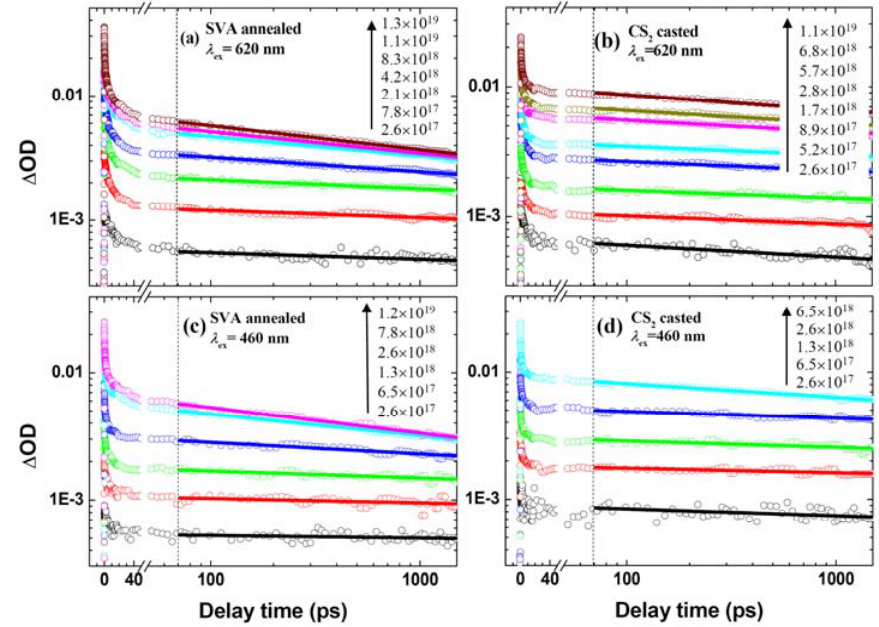
Figure 2. Semi-log plots of the kinetics probed at 1,000 nm under the indicated excitation wavelengths (  ) and photon fluences (in photons  cm − 3 ·pulse − 1 ) for ( a , c ) SVA and ( b , d ) ex -cast P3HT/PC BM blend films (1:1, w/w). Solid lines are the best fits to the power law, CS 2 61 Δ OD( t ) = A  t − α . Vertical dashed lines indicate the occurrence of the delay time of  t = 70